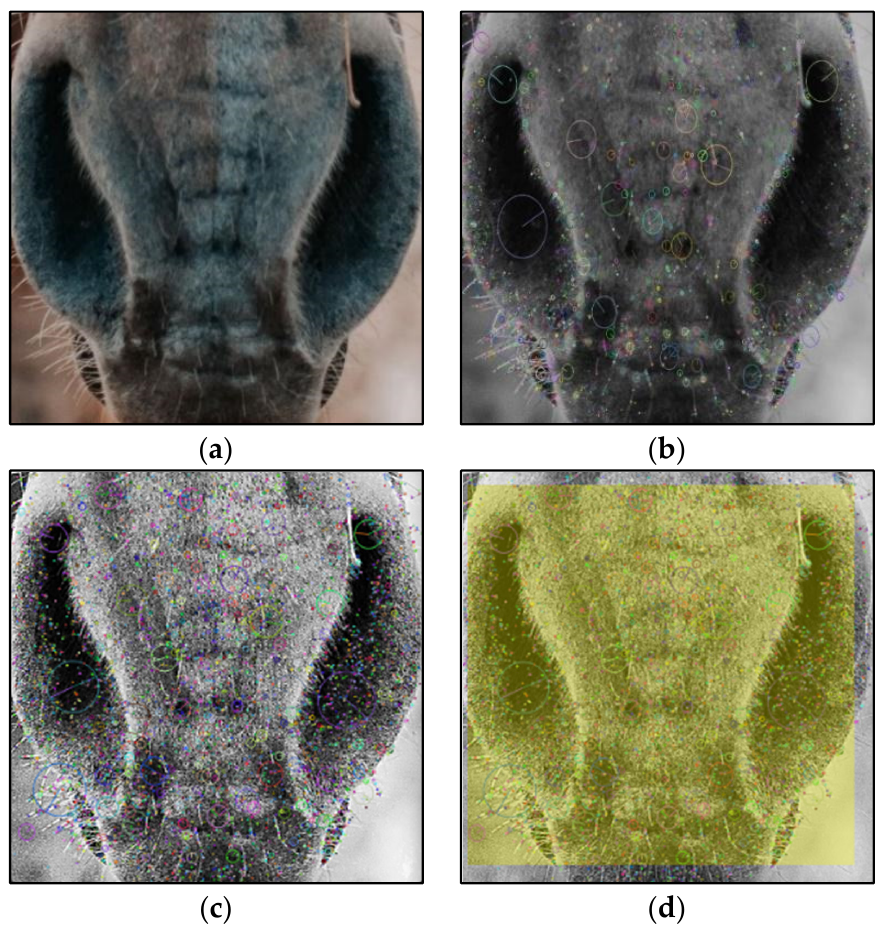
Figure 7. Keypoint detection on muzzle of a horse: ( a ) originally detected by Yolo, ( b ) keypoint detection before processing, ( c ) keypoint detection after processing, and ( d ) region of interest is highlighted, where unique and descriptive features are detected as keypoints.